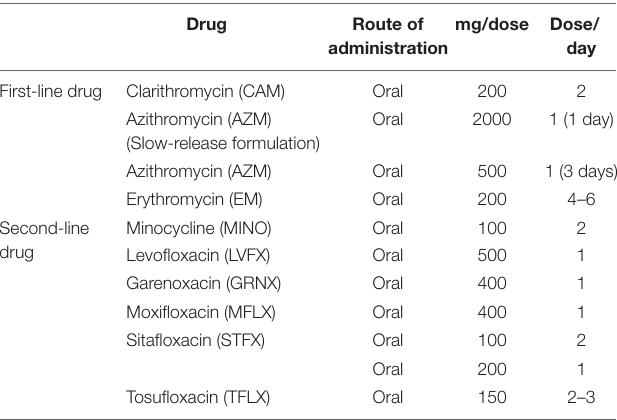
The table is adapted from the guiding principle (Chiryo–Shishin) issued by the Japanese Society of Mycoplasmology (JSM). http://square.umin.ac.jp/jsm/ shisin.pdf.